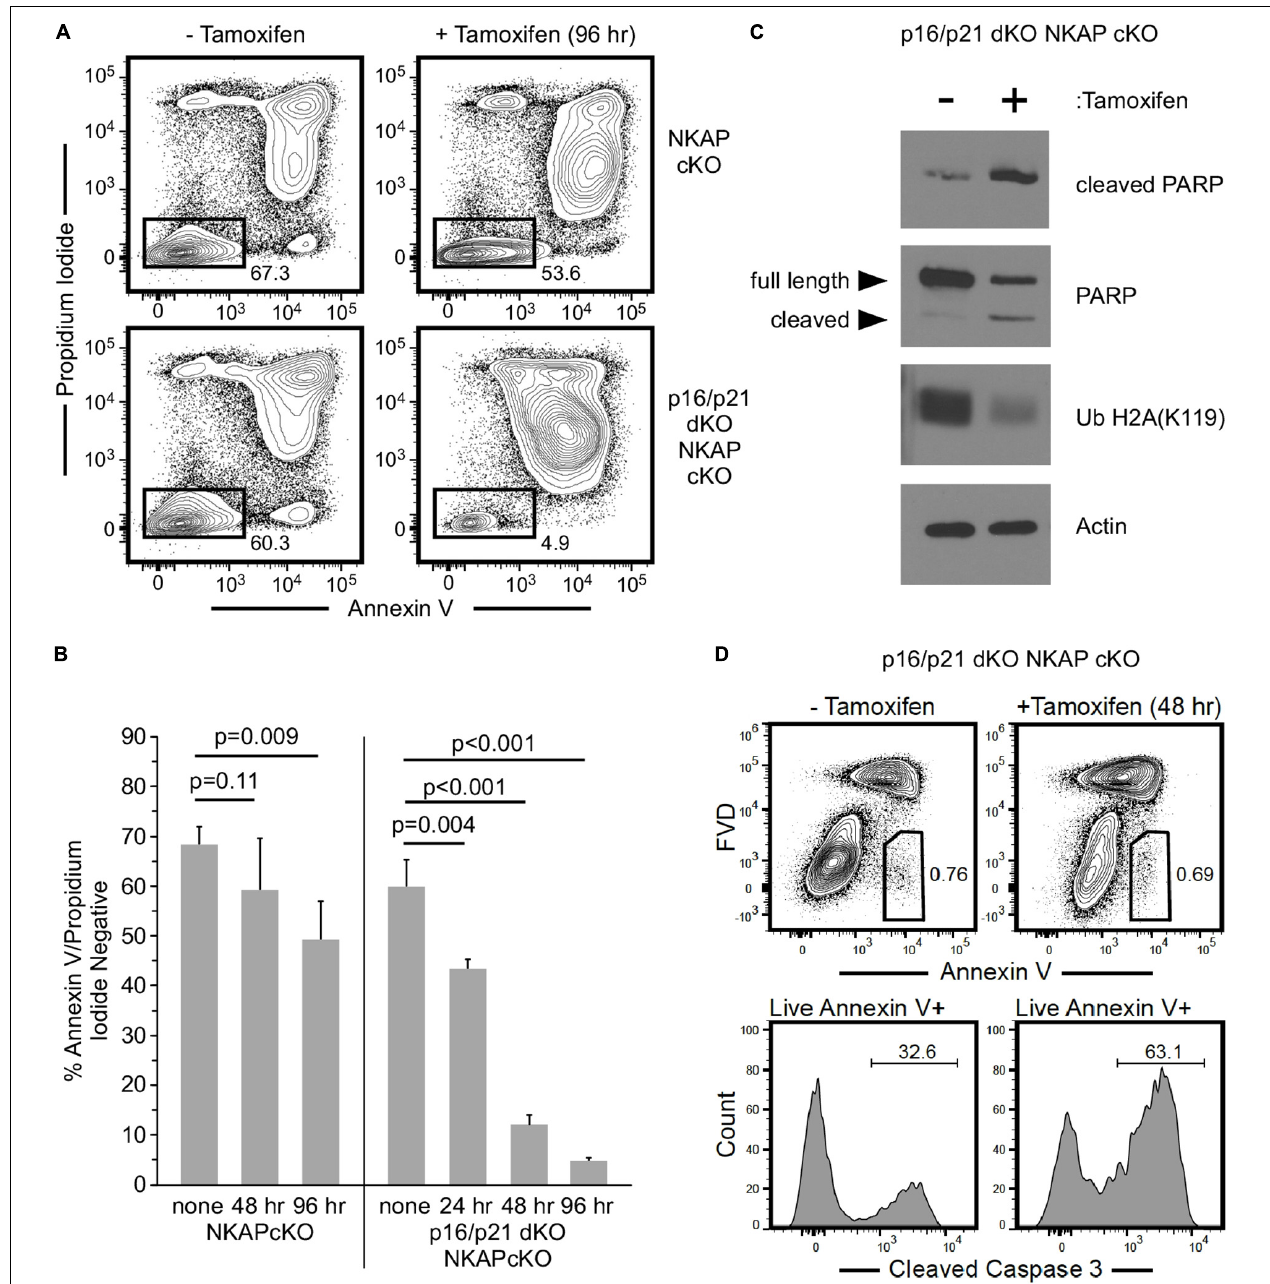
FIGURE 6 | The consequence of NKAP deficiency is modified when CDKI upregulation is impaired in ex vivo cultures. Hematopoietic progenitor cells with a floxed NKAP gene and an ER-cre transgene (NKAP cKO) or cells also deficient in p16 Ink4a and p21 Cip1 (p16/p21 dKO NKAP cKO) were cultured ex vivo and treated with tamoxifen as indicated. Cells were then incubated with Annexin V and propidium iodide followed by flow cytometry to analyze apoptosis. (A) Representative flow cytometry data is shown for cells either left untreated or treated with tamoxifen for 96 h. ER-cre NKAP cKO cells are presented in the upper panels, and p16/p21 dKO ER-cre NKAP cKO are presented in the lower panels. As shown, the cells were divided into two populations, those labeled both by Annexin V and propidium iodide (apoptotic/dead), and those labeled by neither (viable). (B) The percent of viable cells was determined in cultures treated with tamoxifen for the indicated time periods or left untreated (none). Data shown is averaged from three independent experiments initiated from separate pairs of mice. (C) Lysates were generated from equal numbers of p16/p21 dKO ER-cre NKAP cKO cells either left untreated or treated with tamoxifen for 48 h and analyzed by western blotting. Lysates were examined with an antibody specific for the cleaved form of PARP, an antibody to total PARP (recognizing the full length and cleaved proteins), and an antibody to Ub H2A(K119). Actin was analyzed as a loading control. Data shown is representative of analysis performed on three separate cultures initiated from different mice. (D) p16/p21 dKO ER-cre NKAP cKO cells were either left untreated for treated with tamoxifen for 48 h and analyzed by flow cytometry for Annexin V binding in the presence of FVD (upper panels). Annexin V + FVD- live cells were examined for the presence of cleaved caspase-3 (lower panels). Data shown is representative of two separate cultures initiated from different